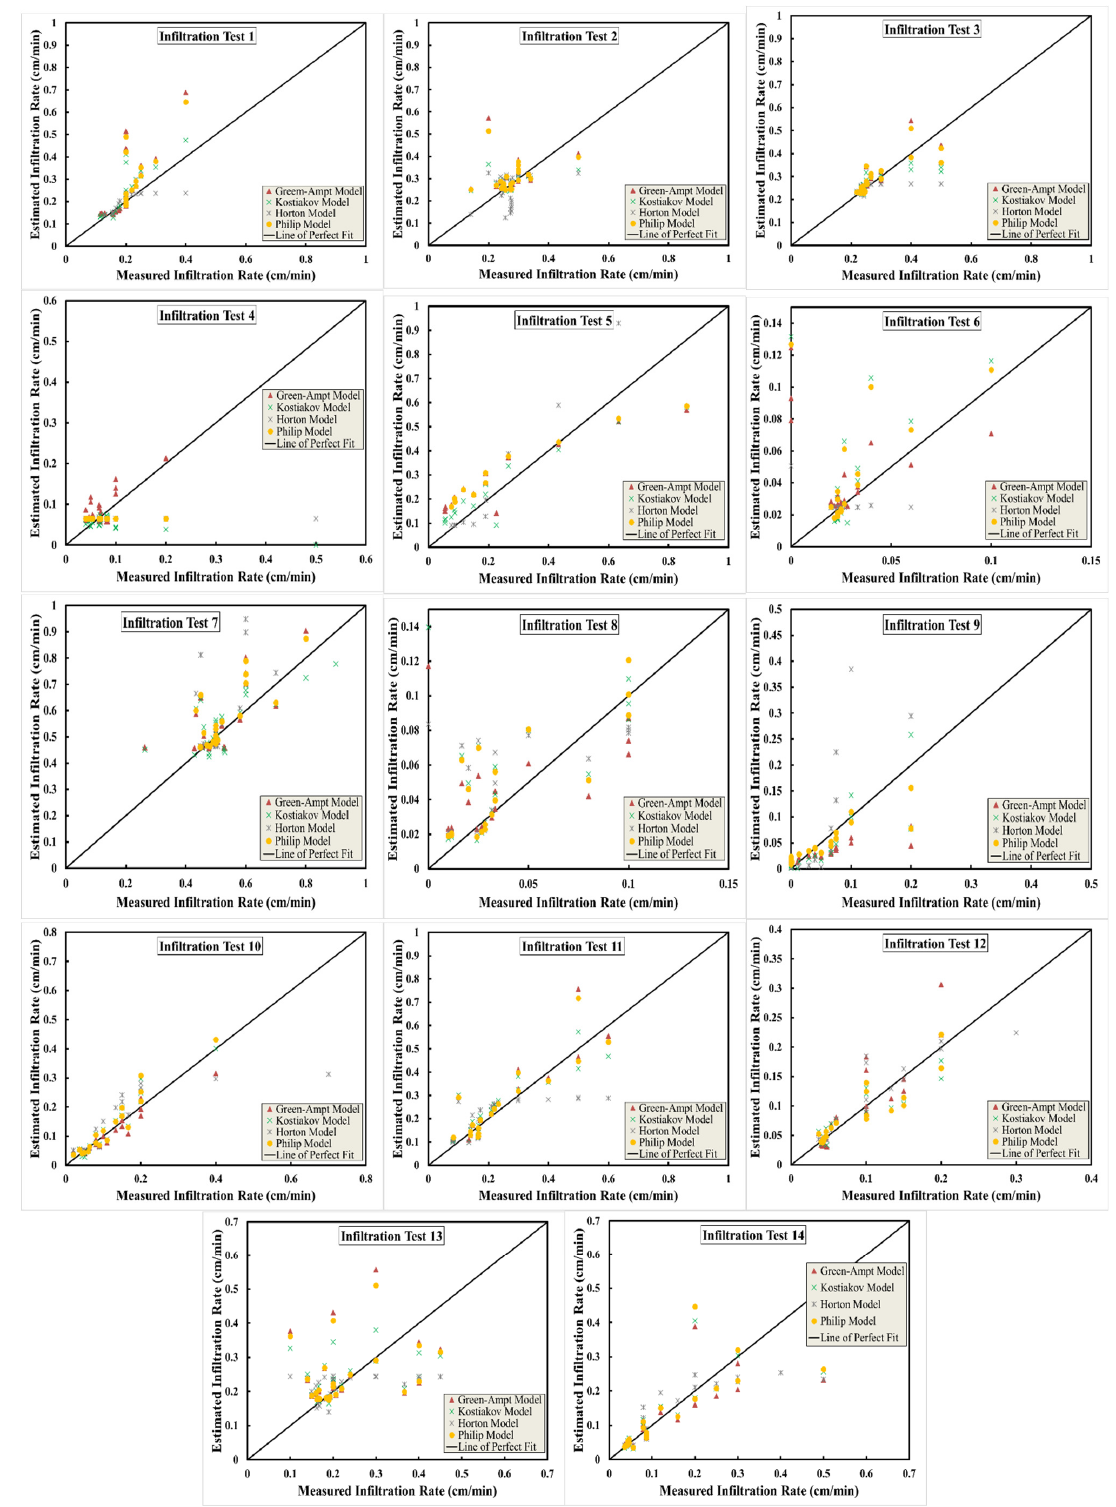
Figure 11. Comparison between infiltration rates estimated from various infiltration models and measured infiltration rates.